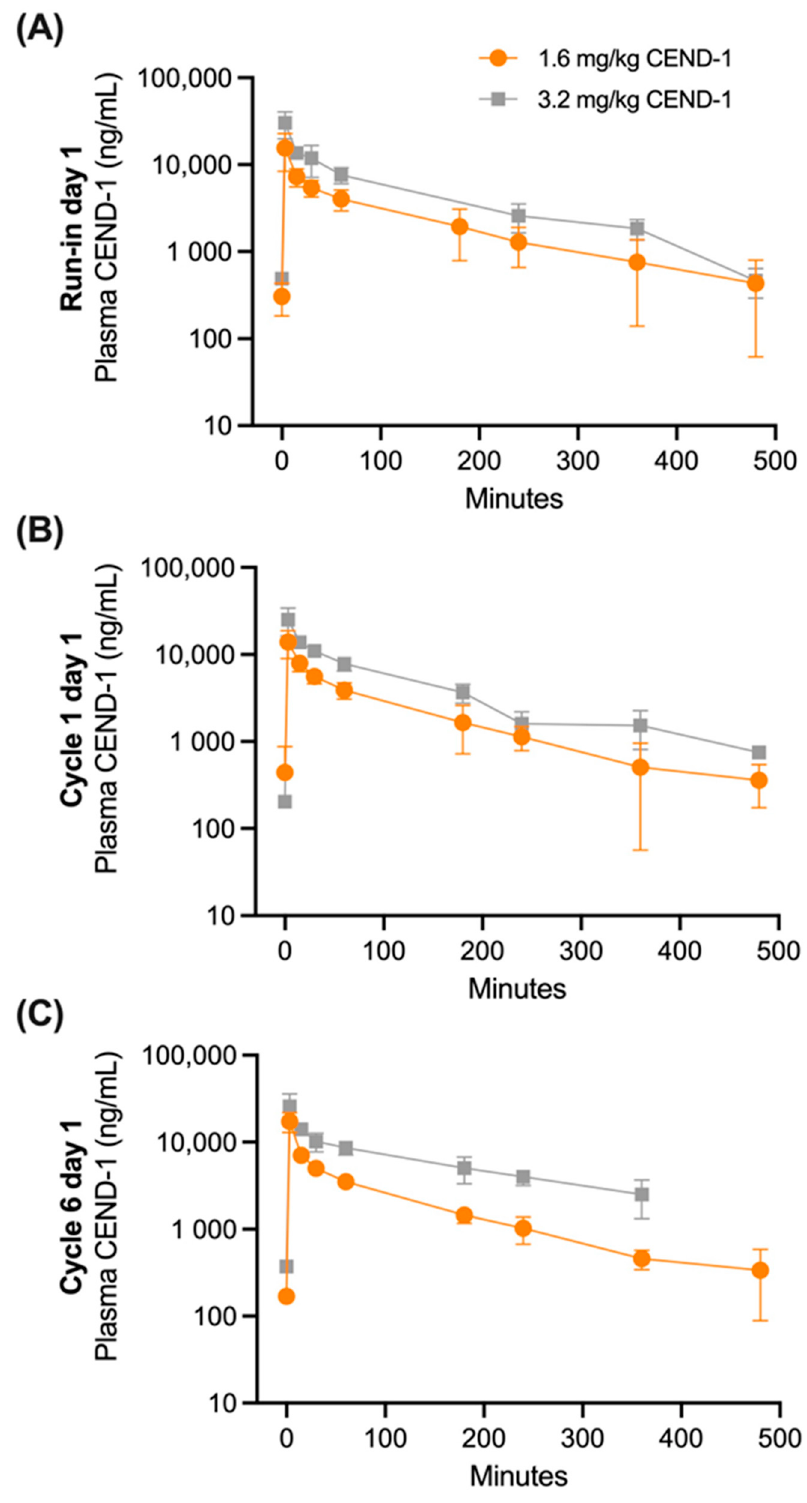
Figure 1. Mean ( ± SD) plasma CEND-1 concentrations over time in pancreatic cancer patients by dose level (1.6 mg/kg or 3.2 mg/kg) at ( A ) run-in prior to chemotherapy treatment ( n = 7–14 patients), ( B ) cycle 1 day 1 of nab-paclitaxel+gemcitabine chemotherapy treatment (N = 9–14) and ( C ) cycle 6 day 1 of nab-paclitaxel+gemcitabine chemotherapy treatment ( n = 1–8).